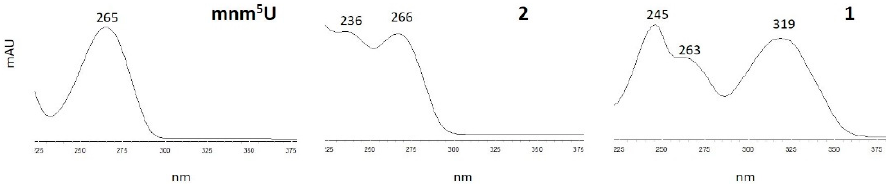
Figure 1. HPLC trace of the oxidation of 5-methylaminomethyl uridine (mnm 5 U) (20 µM) with KHSO 5 (2 mM) for 10 min in 50 mM phosphate buffer at pH 7.5. Conversion 50%.